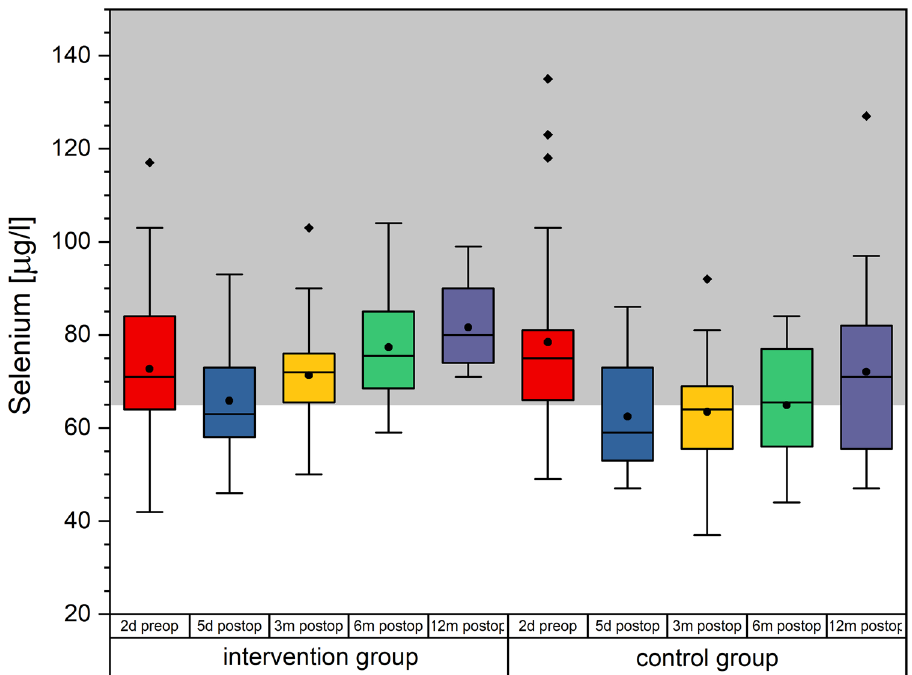
Figure 10. Selenium separately for the intervention and the control group over time. The boxes contain the 25% and the 75% quartile as well as the median, black dots depict the mean, and whiskers range from the 5% percentile to the 95% percentile. Gray areas depict the normal range for